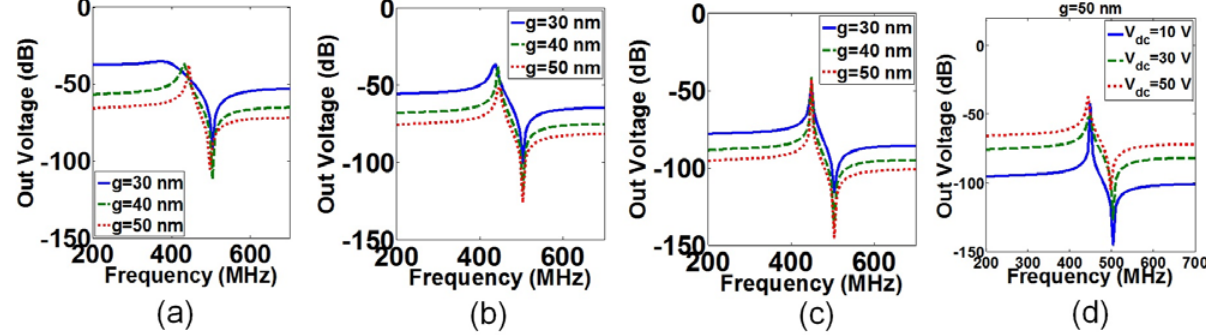
Figure 4. The out voltage of the in-plane resonant suspended gate field-effect-transistor (IP RSG-FET) sensor versus frequency at V = 10 mV for different gaps at: ( a ) V d ( b ) V = 30 V and ( c ) V = 10 V. ( d ) The out voltage of the IP RSG-FET sensor versus dc dc frequency for g = 50 nm at different V dc